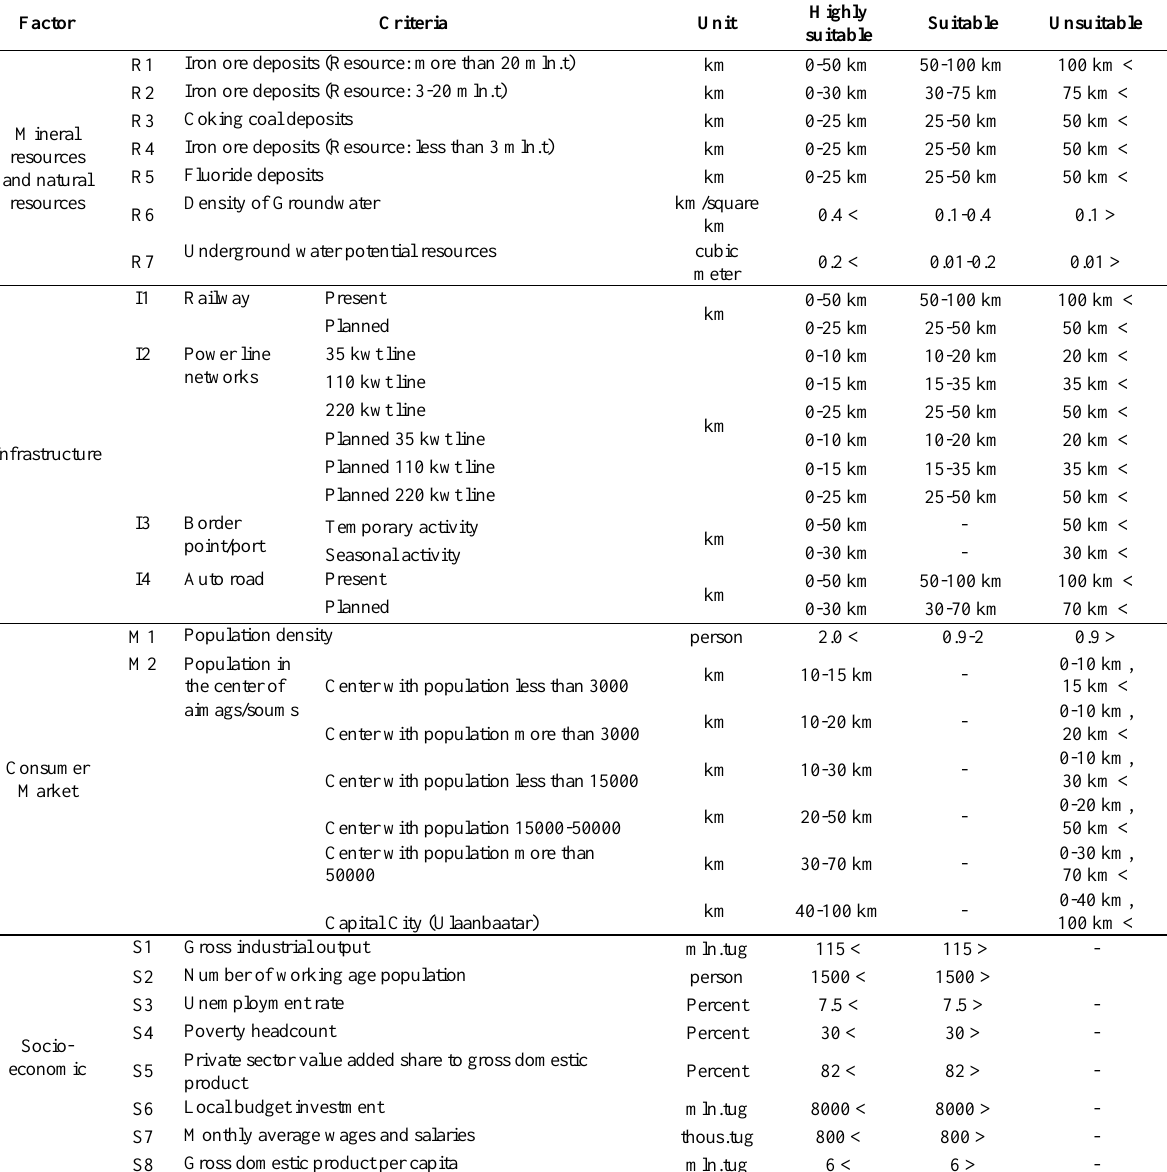
Table 3. Evaluation of the multi –variable criteria